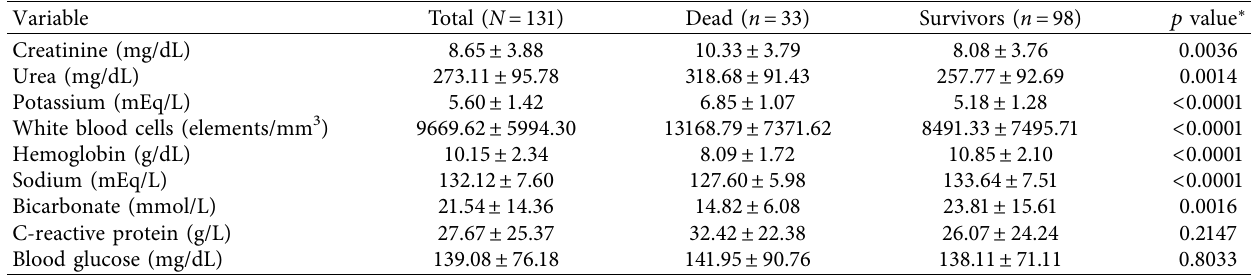
Table 3: Comparison of the mean values for laboratory investigations between deceased and survivors at the CIMAK hemodialysis centre in North-Kivu province in the